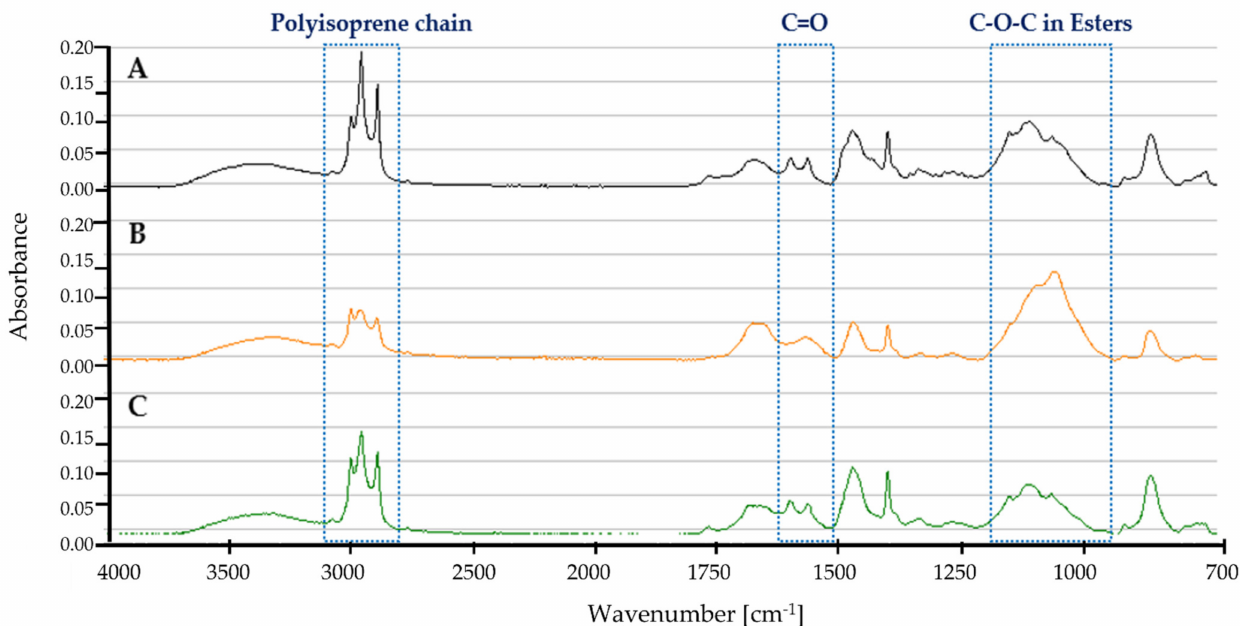
Figure 8. ATR-FTIR profile for fresh latex pieces as carbon source in MSM broth for 30 days, 28 ◦ C, 180 rpm ( A ) Control